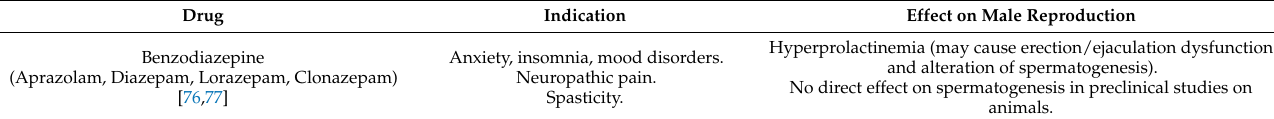
Anxiety, insomnia, mood disorders. Neuropathic